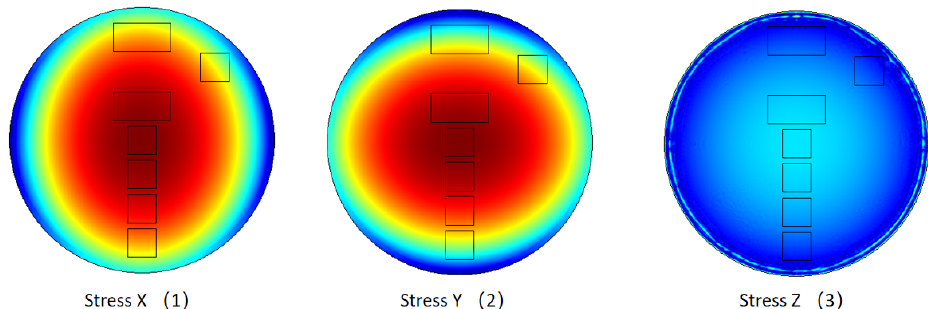
Figure 9. The internal stress field of the PVDF layer in the three directions computed by the FE model.